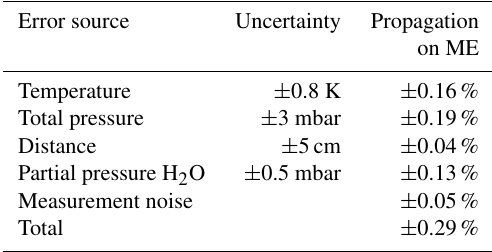
Table 1. Estimated ME uncertainties for various error